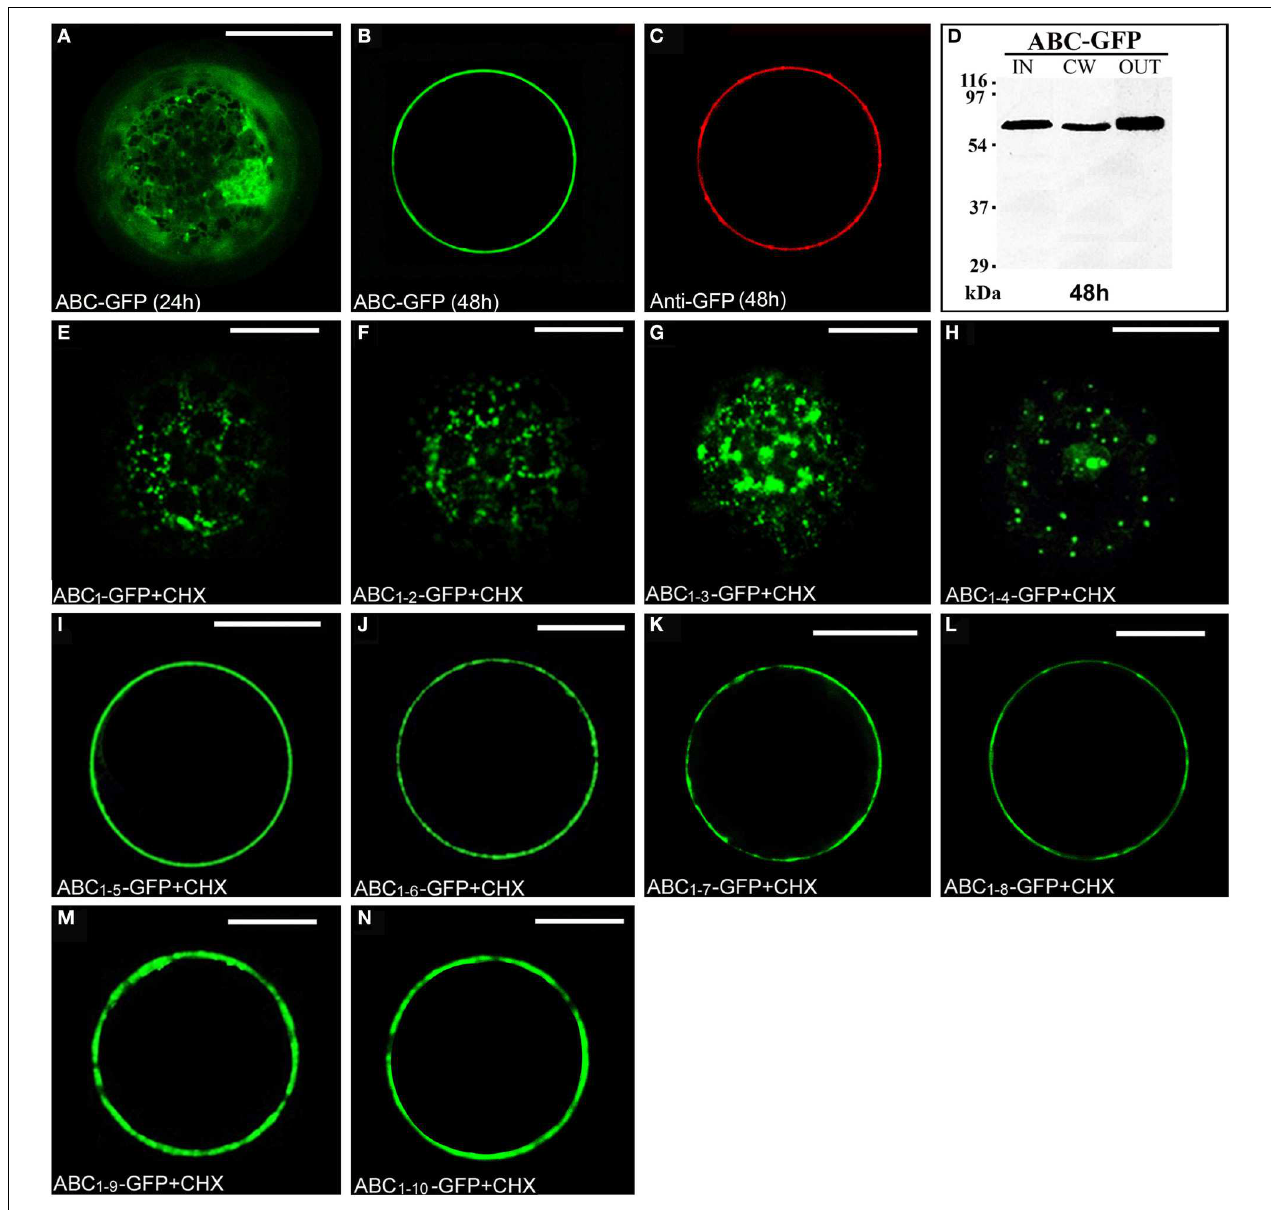
obtained from ABC-GFP transformed protoplasts. (E–H) Chimeras containing from 1 to 4 LRRs of PGIP2 C domain localized in small punctate structures. (I–N) Constructs containing from 5 to 10 LRRs accumulated outside the cell. All tobacco leaf protoplast transformations were performed in the presence of cycloheximide (CHX) (30 µ g · mL − 1 ). All the fluorescent patterns were representative of more than 95% of the observed protoplast populations. Three independent transformation experiments were performed for each construct, and approximately 100 transformed protoplasts were counted each time. Bands were detected using anti-GFP serum. Scale bars = 20 µ